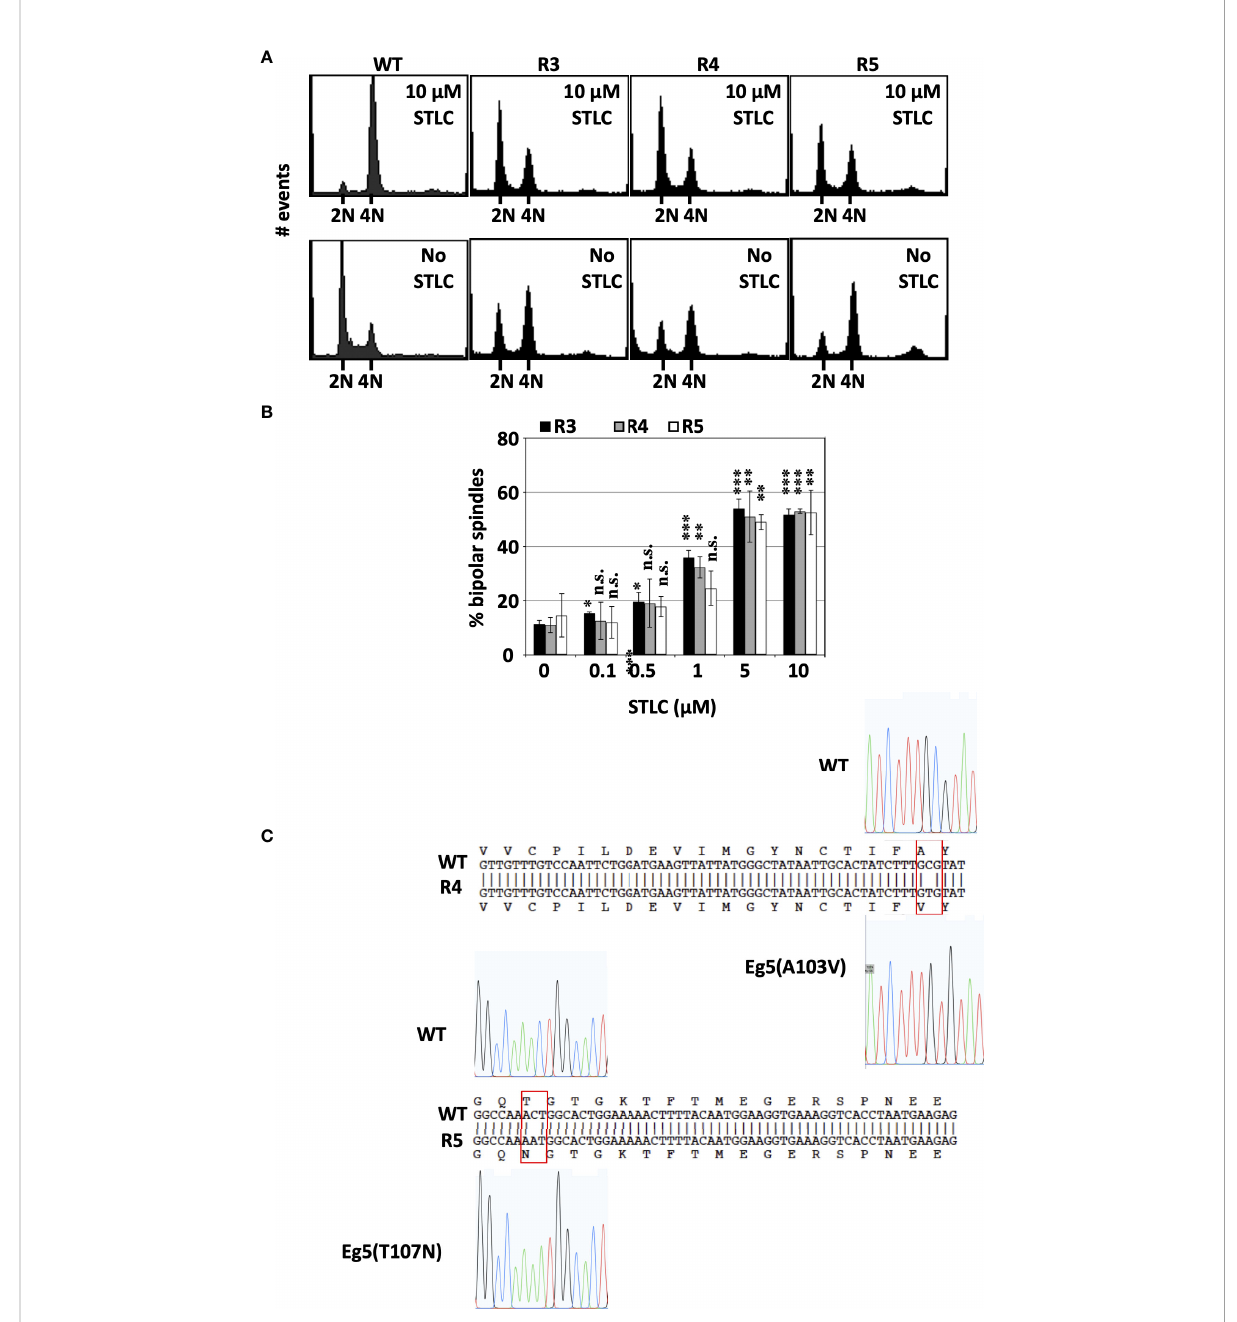
FIGURE 4 STLC resistance and dependence is linked to expression of mutant Eg5 (A) Cell-cycle pro fi les of unselected wild type HCT116 cells and STLC- resistant and -dependent clones, R3, R4 and R5 exposed to STLC (10 m M) (upper panels) and 24h following wash-out of STLC (lower panels). (B) The % of bipolar spindles in cell lines R3, R4 and R5 increase with increasing STLC concentration. Asterisks indicate signi fi cance values; ns – non-signi fi cant; * p < 0,01, **± p < 0,001, *** p< 0,0001. (C) DNA sequences of Eg5 (KIF11) cDNAs in WT and STLC-resistant and -dependent clones, R4 and R5 and the identi fi ed corresponding missense mutations. Clone R3 expressed the same T107N mutant Eg5 as the one identi fi ed in clone